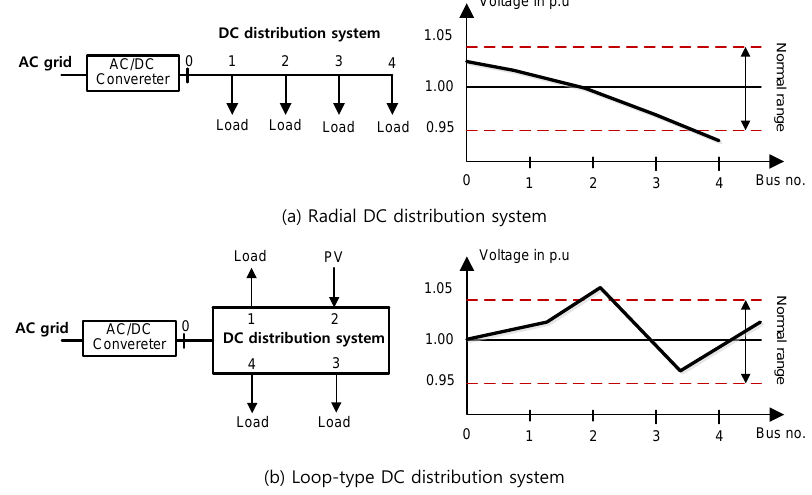
Figure 1. Voltage profile in ( a ) DC radial network; ( b ) loop network.